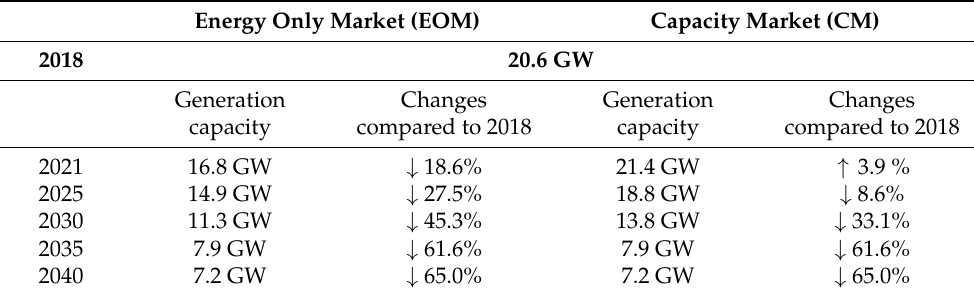
Table 4. Generation capacity in hard coal-fired power generation units.